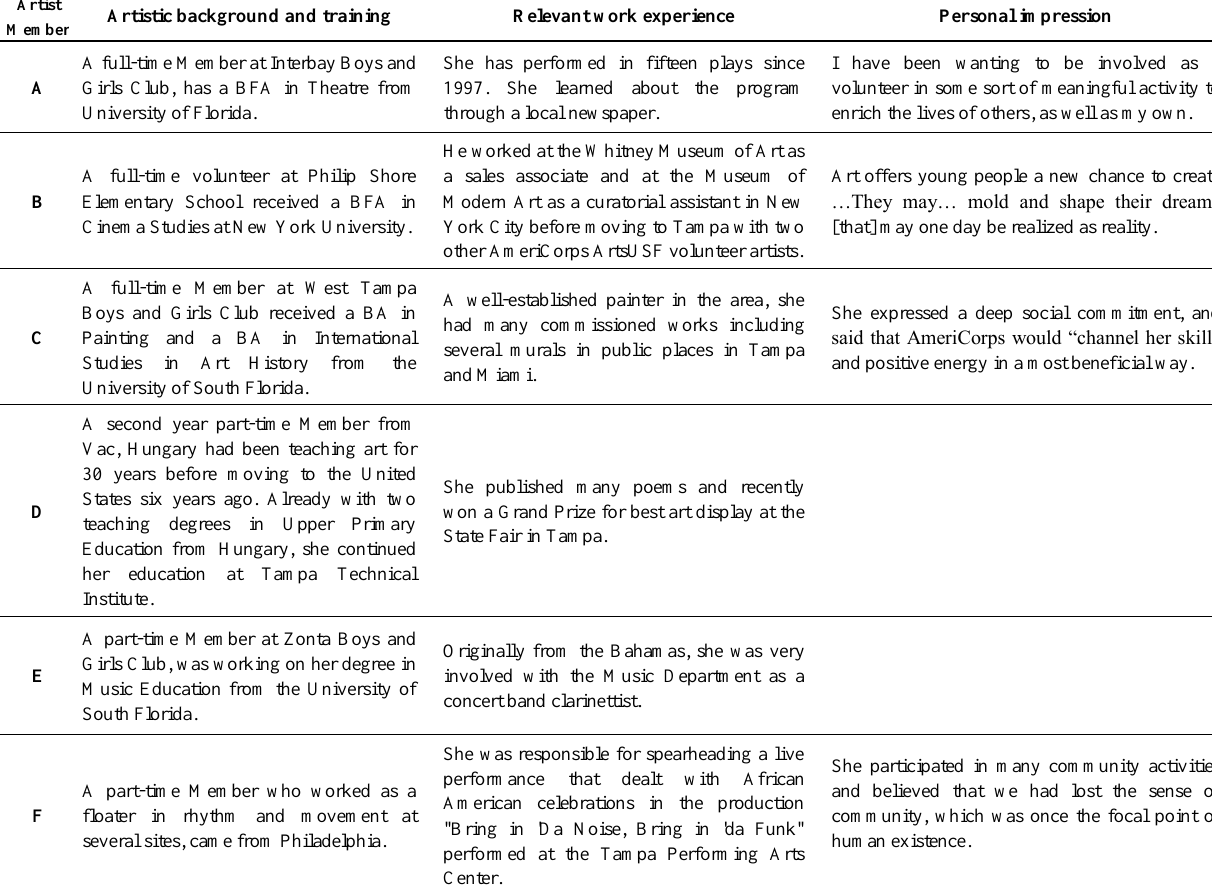
Table 4. Sample Artist Member